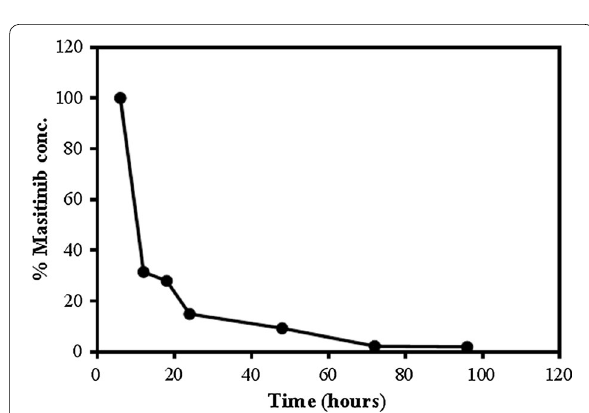
Fig. 5 Excretion rate of MST in Sprague Dawely rats after single oral dose of 30.8